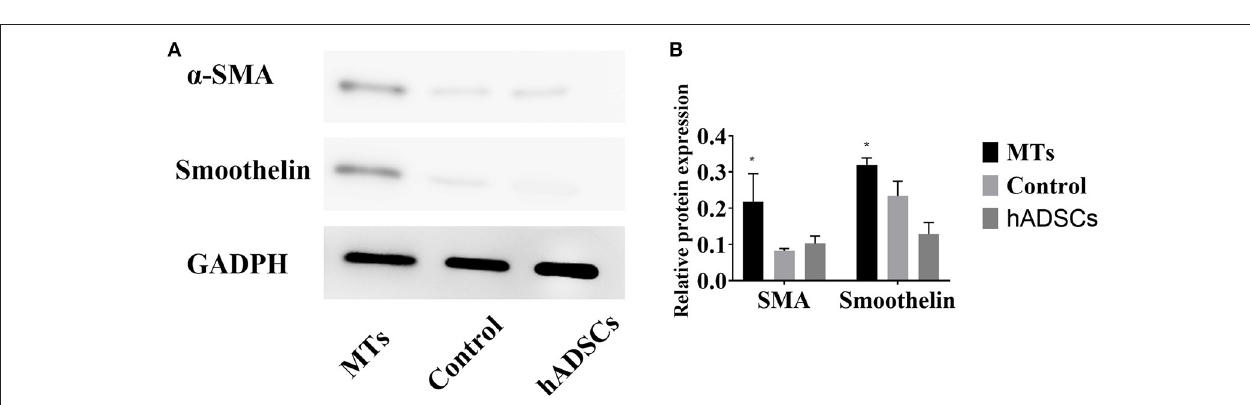
FIGURE 5 | (A) western blotting compared the relative protein expression of α -SMA and smoothelin in microtissues (MTs) and induced monolayer cultured hADSCs (control) and non-induced hADSCs (hADSCs); (B) Semi-quantitative data of relative protein expression (target protein/GADPH). * P < 0.05 vs. the control and hADSCs.